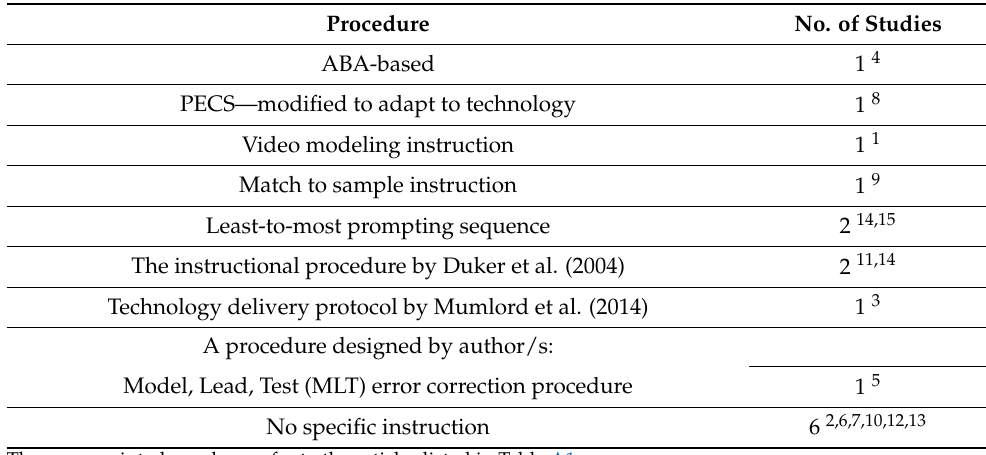
Table 7. Summary of the intervention